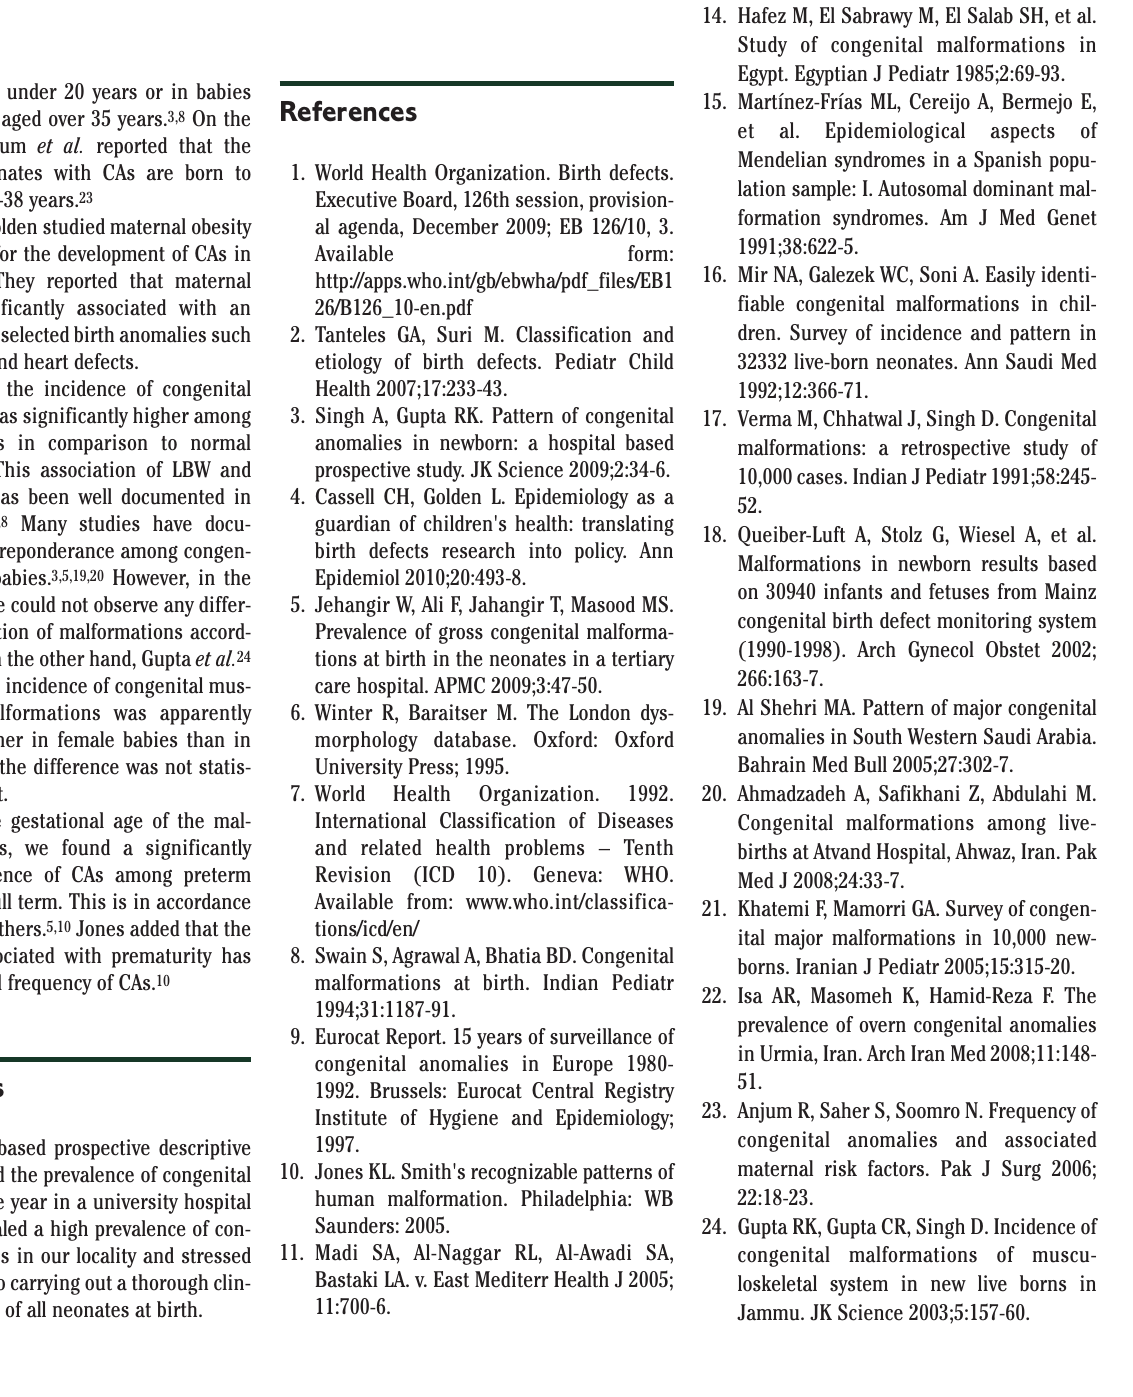
Figure 4. Ambigeous genitalia; bilateral club foot;